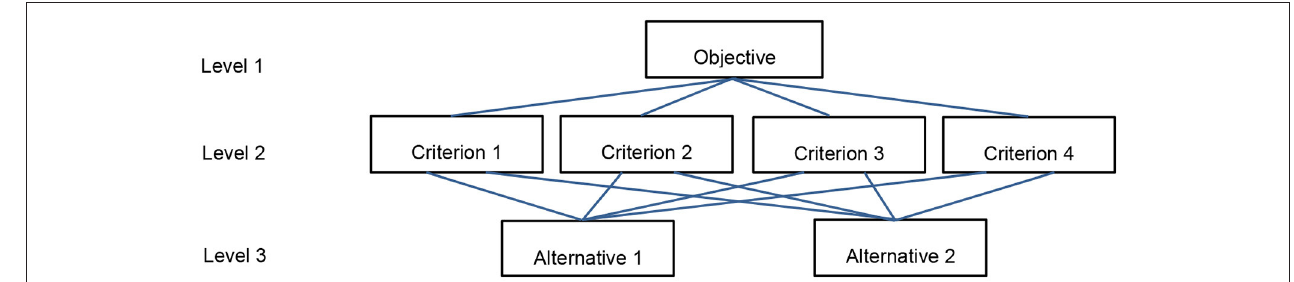
FIGURE 2 | Structured problem with three different hierarchy levels (Chandio and Matori, 2011).